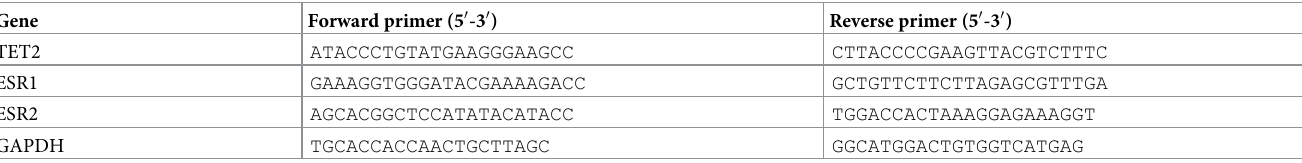
Table 2. Primers used for RT-qPCR.